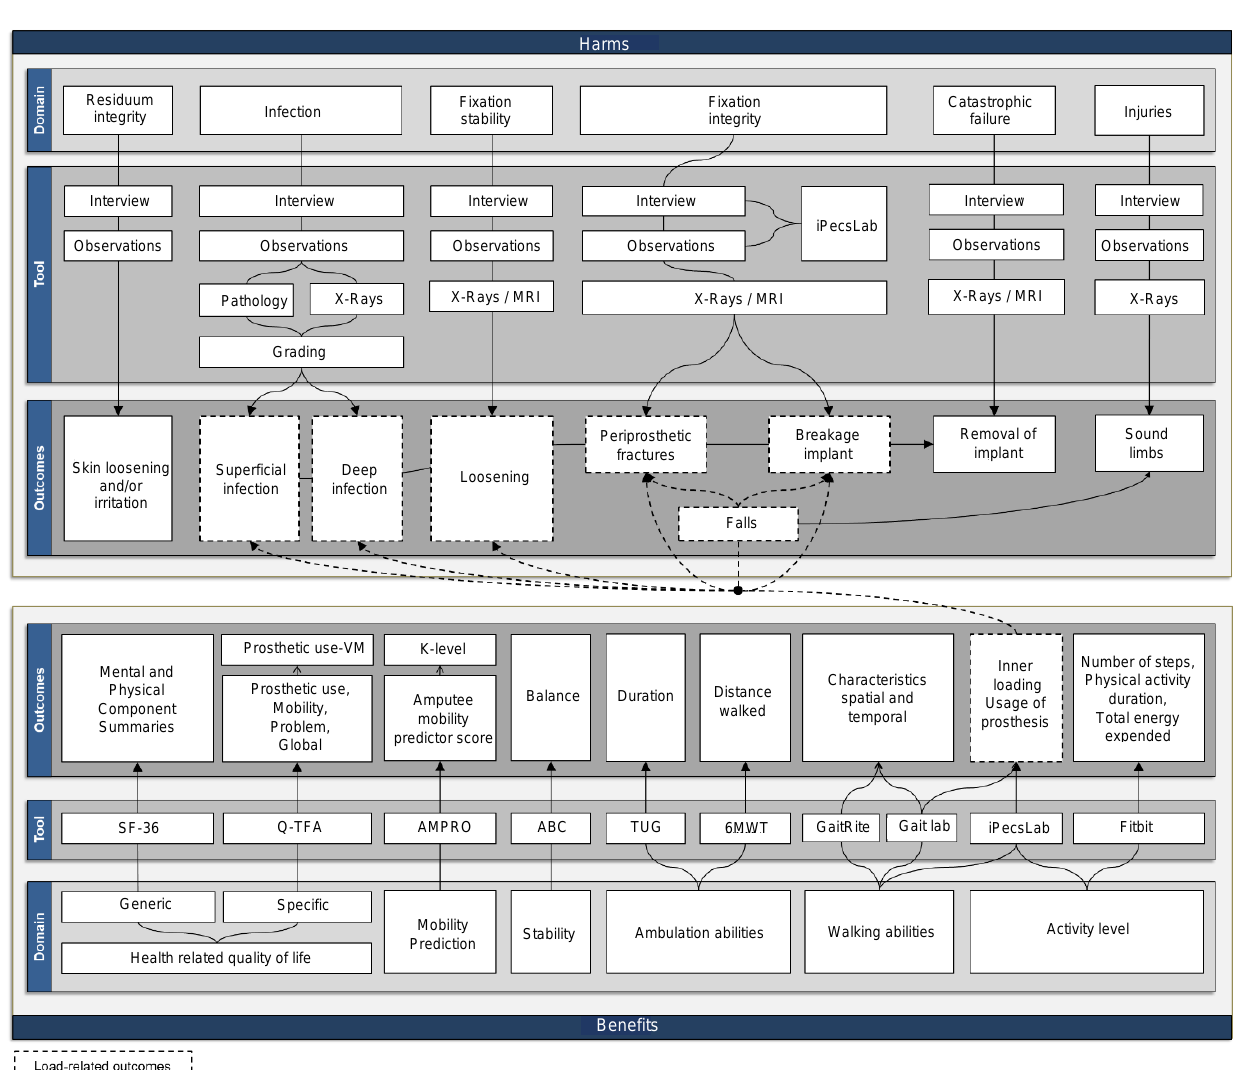
Figure 7: Overview of evaluation framework to extract clinical benefits and harms including prosthetic load-related outcomes (SF-36: 36-Item Short Form Survey, Q-TFA: Questionnaire for Persons with a Transfemoral Amputation, AMPRO: Amputee mobility predictor, ABC: Activities- specific Balance Confidence scale, TUG: Timed Up and Go test, 6MWT: 6-minute walk test, GaitRite (CIR Systems Inc, USA), Gait laboratory equipment (e.g., 3D motion capture, force plates), iPecsLab (RTC electronics, USA), Fitbit (Fitbit Inc, USA)).